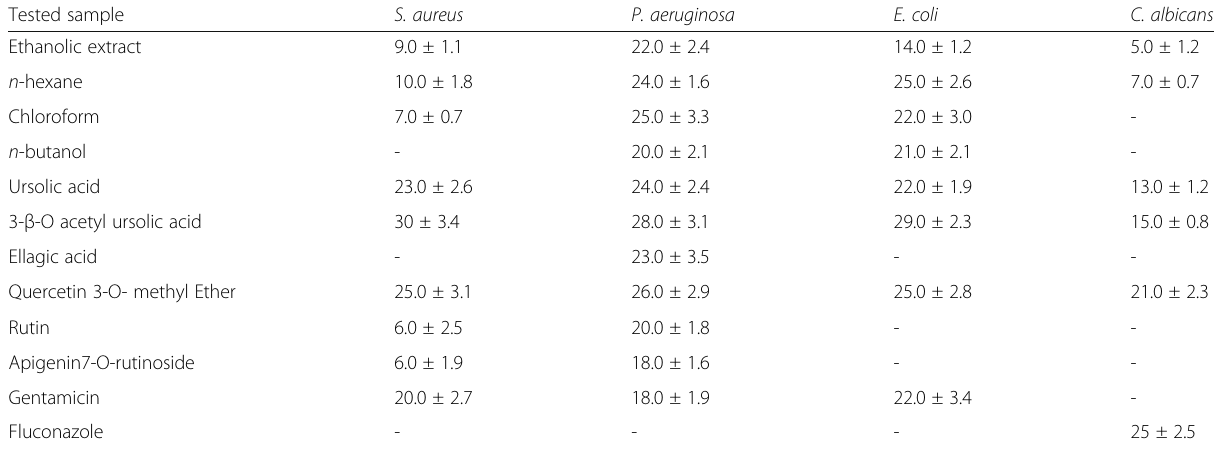
Table 6 Antimicrobial activity of the ethanolic extract, fractions and isolated compounds of C. azarolus var. eu- azarolus leaves (zone of inhibition, mm)